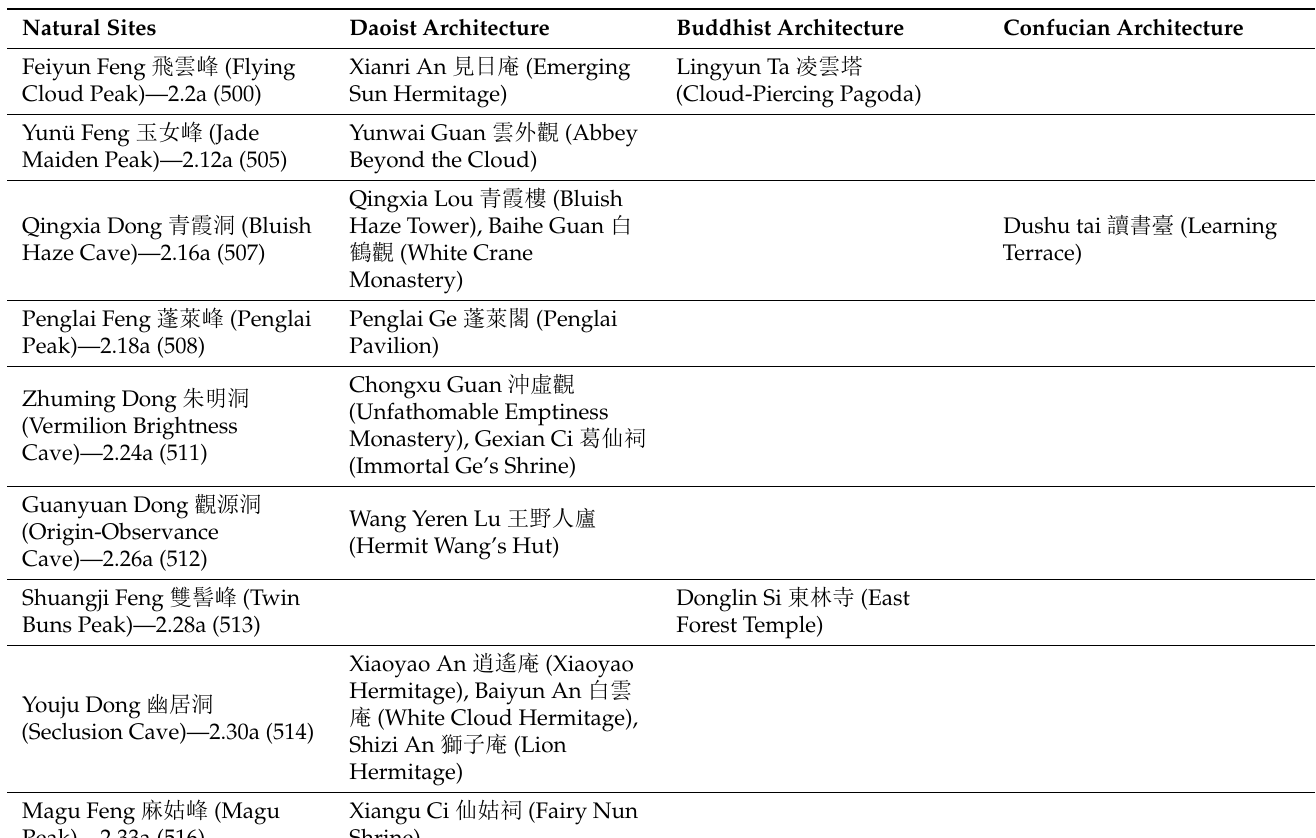
Table 2. Poems Describing Luofu as a Grotto-Heaven Collected in Luofu Yesheng